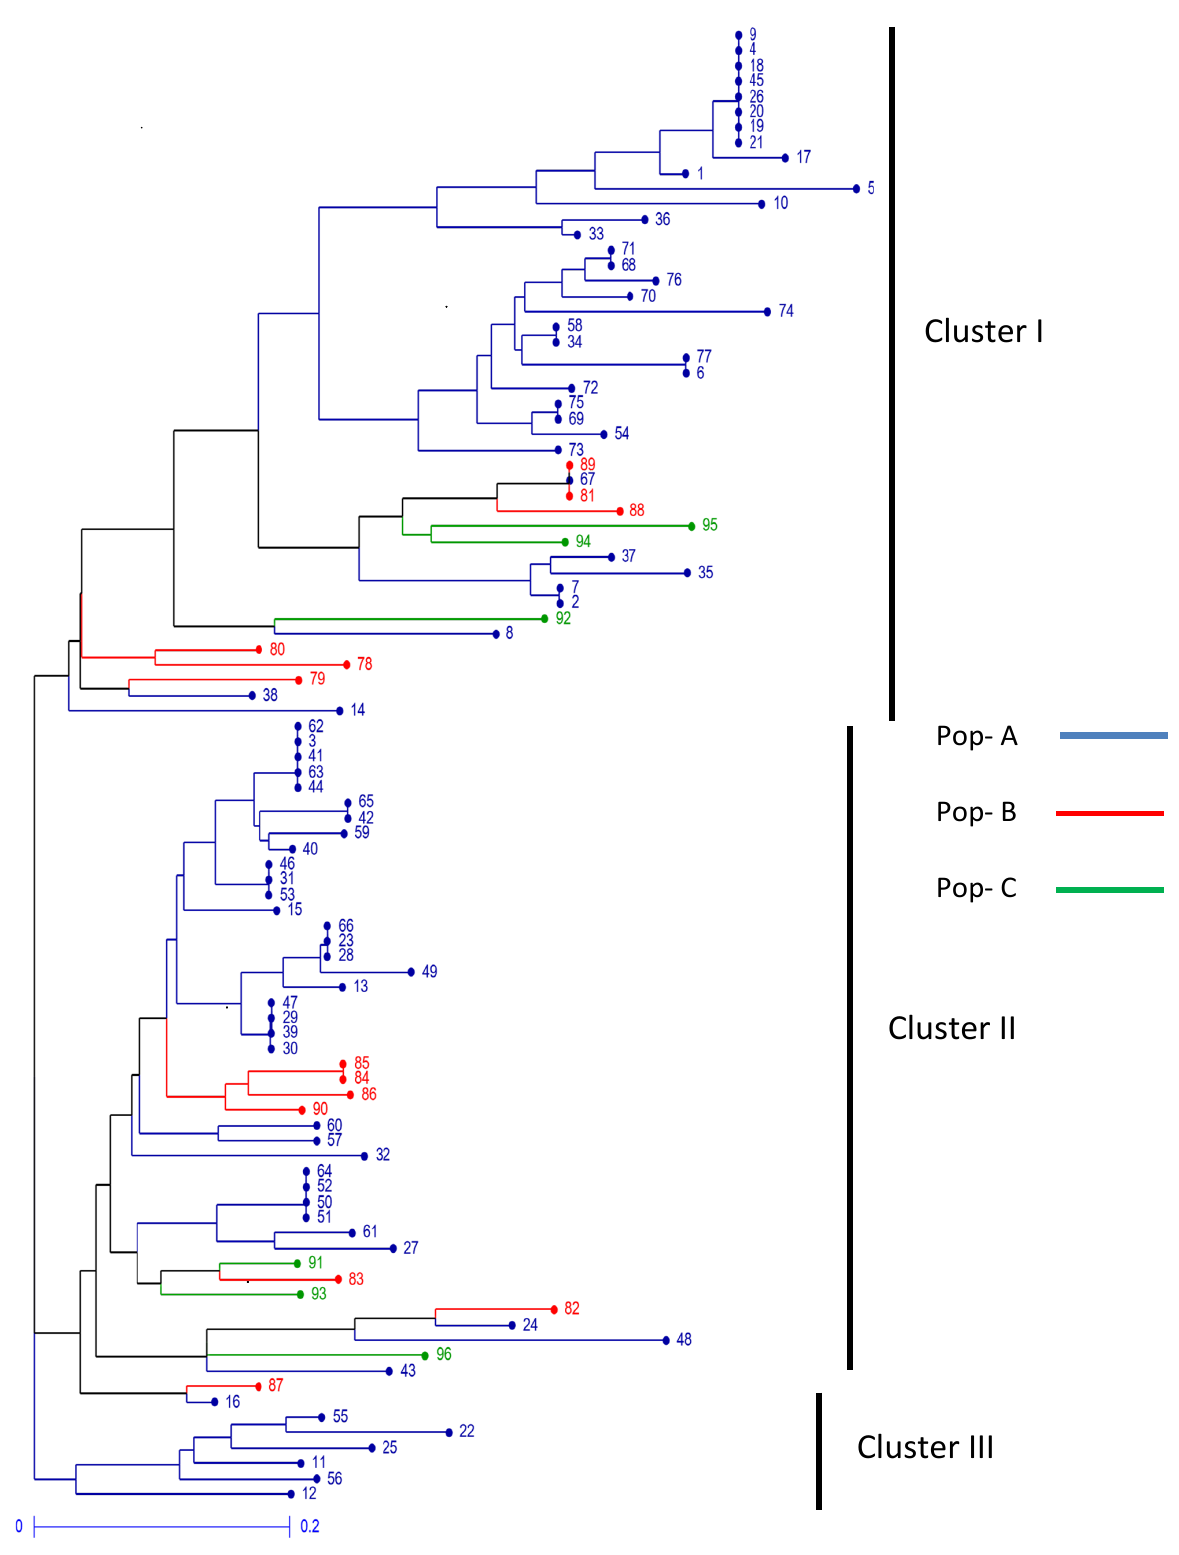
Figure 2. Phylogenetic relationship among 96 isolates constructed using the unweighted neighbor-joining approach with 1000 bootstrap replicates. (The populations are color-coded as follows: blue = Pop-A; red = Pop-B; and green = Pop-C). Principal component analysis (PCoA), which was used to identify genetic variation pattern among D. rabiei isolates, showed that the isolates were roughly grouped